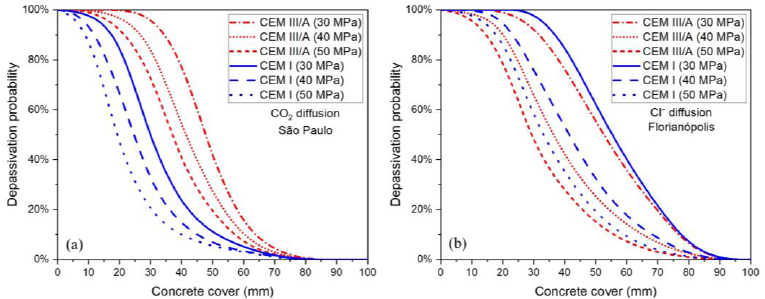
Figure 11. Depassivation probability in function of concrete cover in 50-year-old structure for ( a ) S ã o Paulo and ( b ) Florian ó polis.